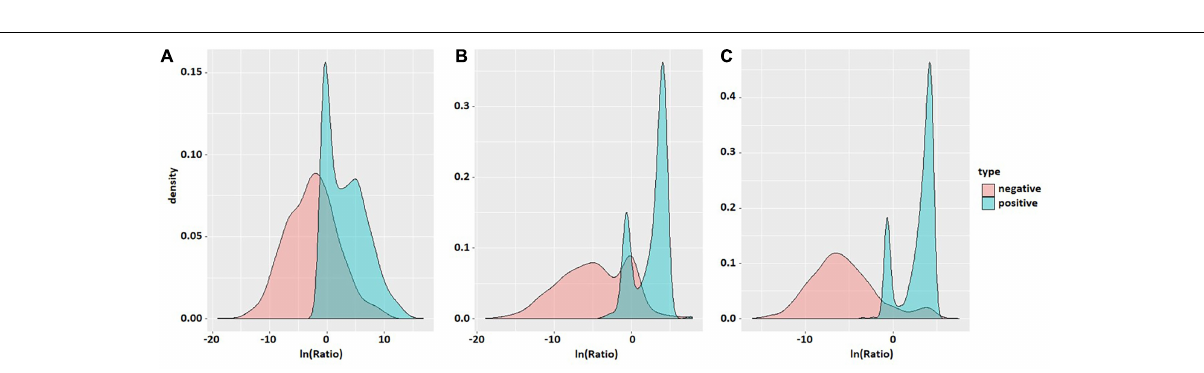
FIGURE 3 | Probability density maps of ln(Ratio) values of the three species. The three density maps (A) , (B) , and (C) correspond to S. cerevisiae , mouse, and H. sapiens . Red is negative and blue is positive.